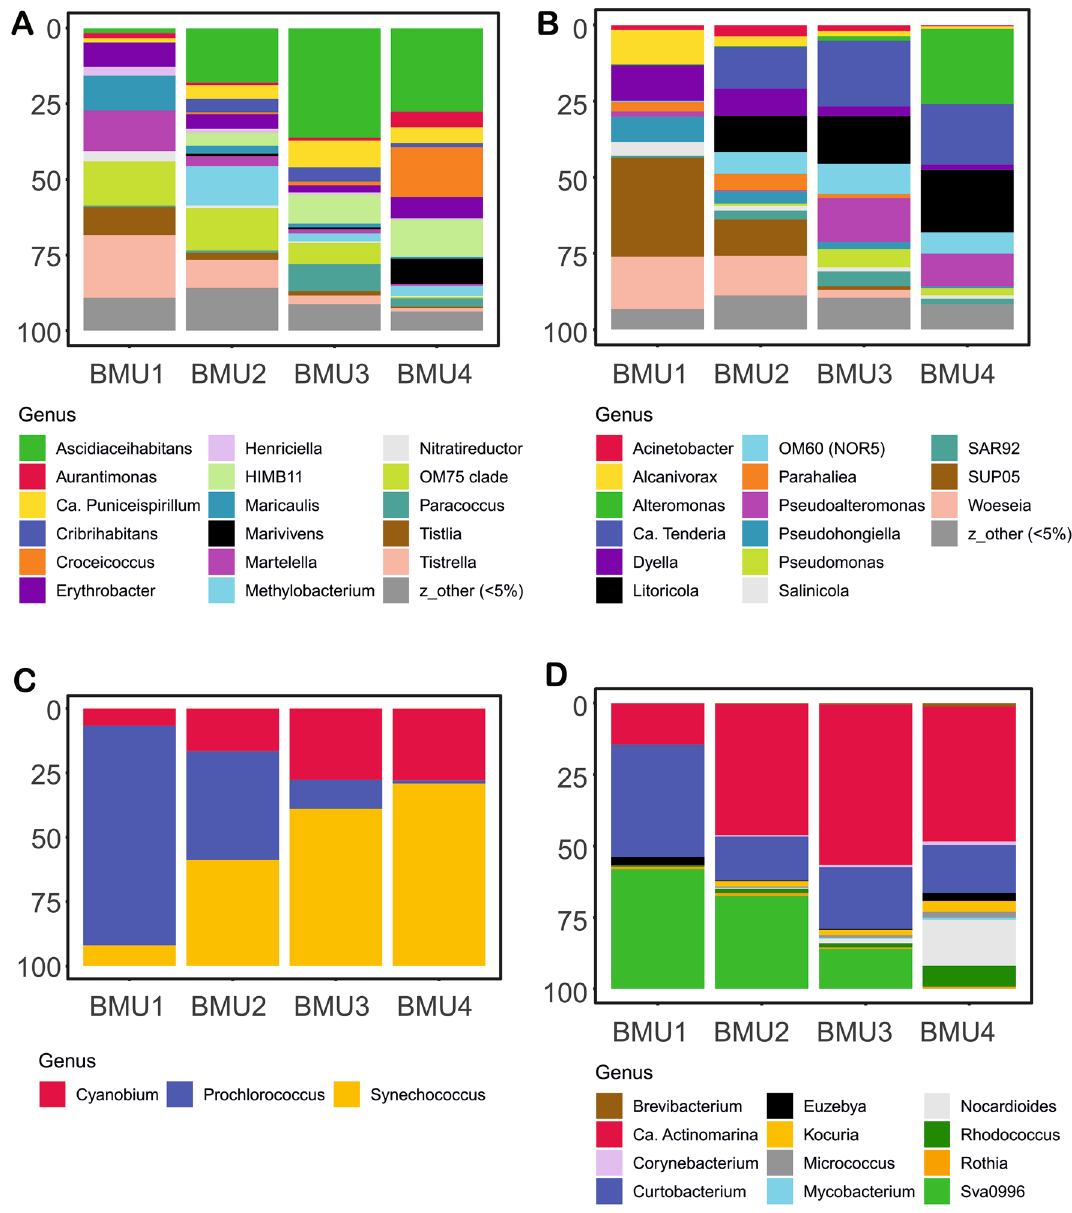
org/ , v. 3.6.3), using ggplot2 v. 3.3.3 package 36 , and they were assembled in Inkscape (https:// inksc ape. org/ ,